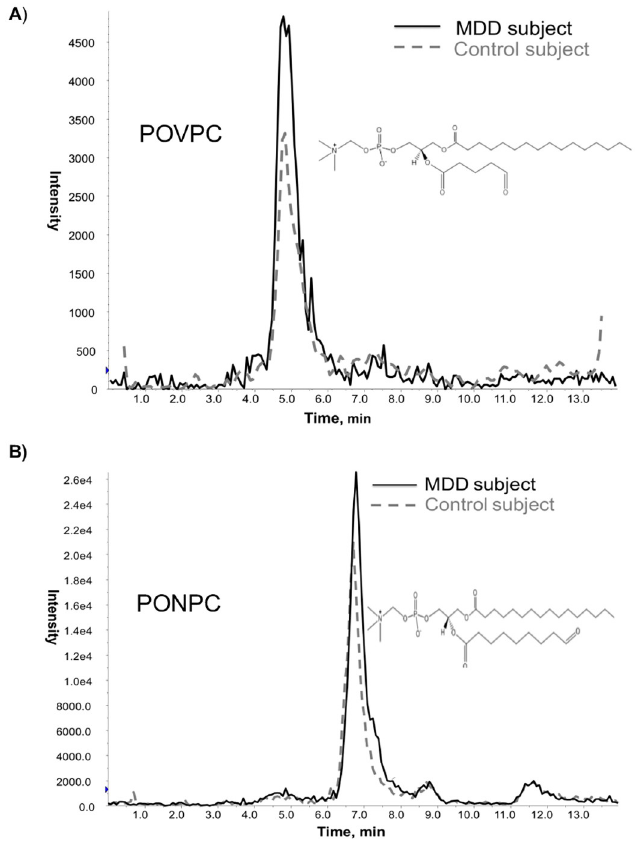
Fig 2. Multiple Reaction Monitoring [MRM] chromatogram of 2 fragmented OxPCs, [A] POVPC and [B] PONPC, in an MDD [black line] and control [dotted line] subject as measured by reverse phase HPLC-MS/MS. Abbreviations: POVPC, 1-palmitoyl-2-[5’-oxo-valeroyl]-sn-glycero-3-phosphocholine; PONPC,1-palmitoyl-2-[9’-oxo- nonanoyl]-sn-glycero-3-phosphocholine.